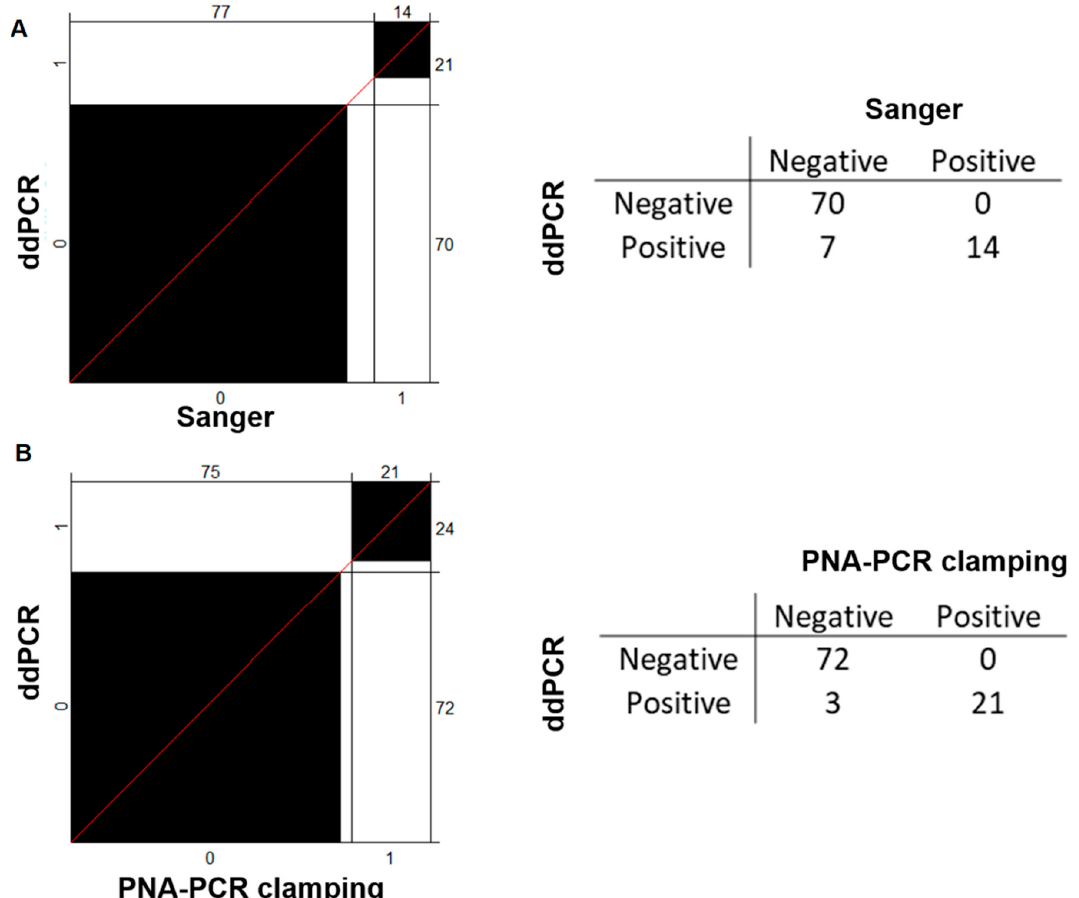
Figure 3. Agreement charts for comparing IDH2 status evaluation techniques. In agreement plots, the black blocks indicate the accordance of results for each method with respect to the ddPCR, selected as a calibrator for the analysis. ddPCR and PNA-PCR clamping ( B ) had a greater agreement with respect to ddPCR and Sanger sequencing ( A ), as also suggested by the shorter segment of the red 45° diagonal line not included in the black blocks. The 2 × 2 tables alongside underline the differences of each methodology with respect to ddPCR.